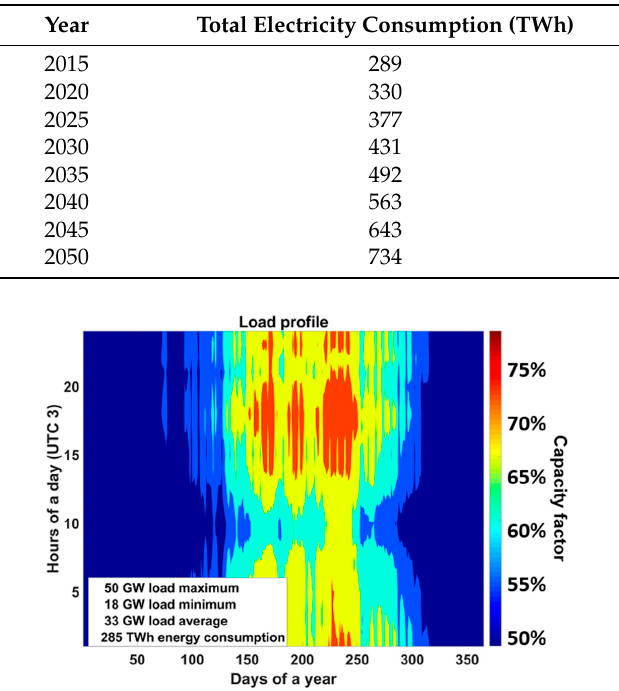
Figure 3. Aggregated load curve for the year 2015 for Saudi Arabia.